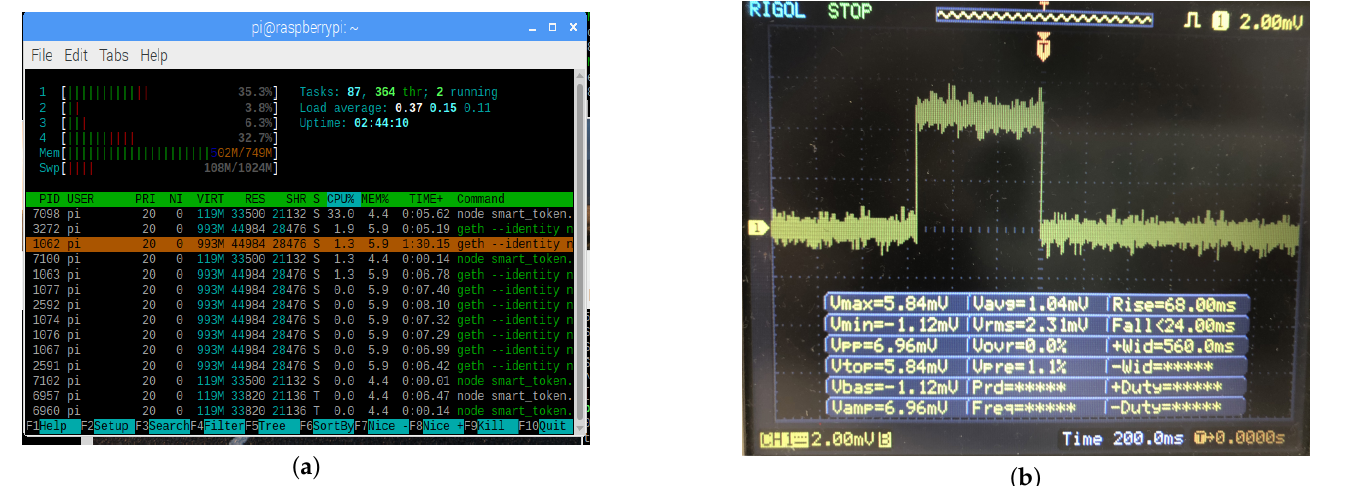
Figure 6. Performance testing experiment captures. ( a ) Htop capture of CPU and RAM memory consumption; ( b ) Execution time and voltage drop waveform for Ethereum